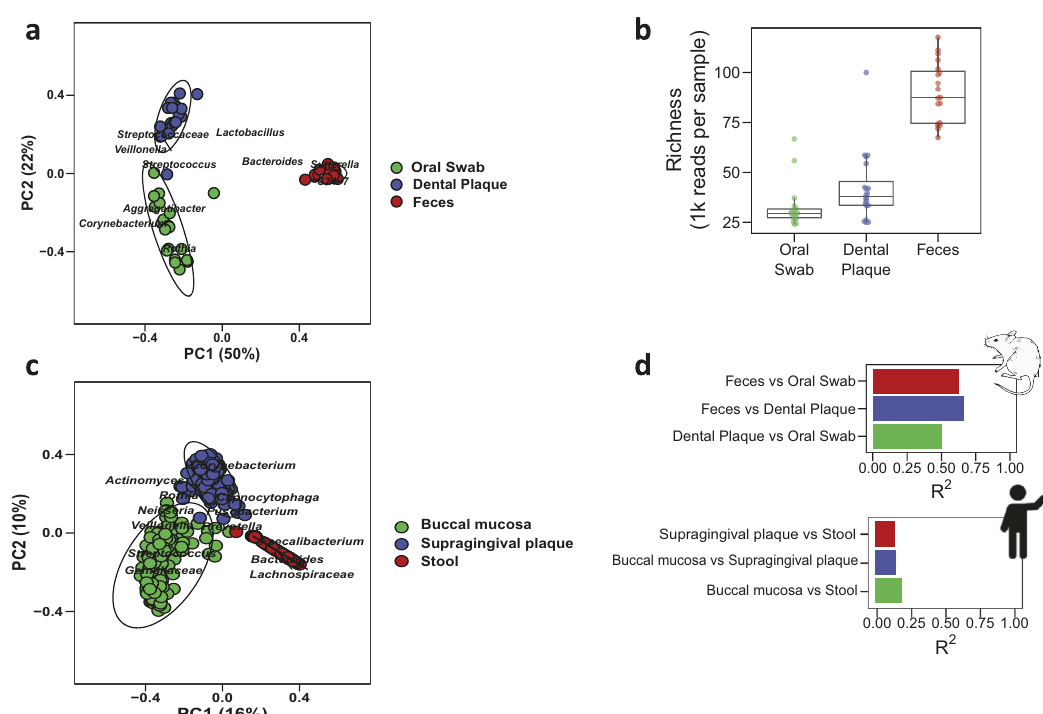
Fig. 2 Unique bacterial communities in rat and human body sites. Sample types corresponding to oral (oral swab and dental plaque) and gut (feces) represented as body sites. a Bray – Curtis distances principal coordinate analysis for rodent samples. Each point corresponds to a sample colored by body site. Circle shapes show 95% con fi dence of the group. b Alpha diversity as richness showed statistical differences between sample types ( P < 0.001, Wilcoxon test). c Beta-diversity using Bray – Curtis distances for the Human Microbiome Project samples showed differences between body sites. d Rat and human body site differences using pairwise PERMANOVA test for Bray – Curtis